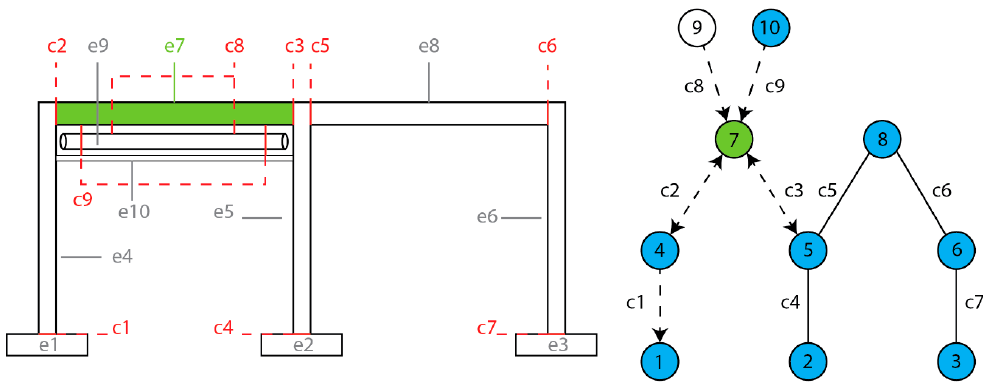
Figure 5. Visualization and disassembly network of the first case focusing on the extraction of the beam e7 from the structure. By convention, the element in green is always the element that is considered to be recovered and elements in blue are directly